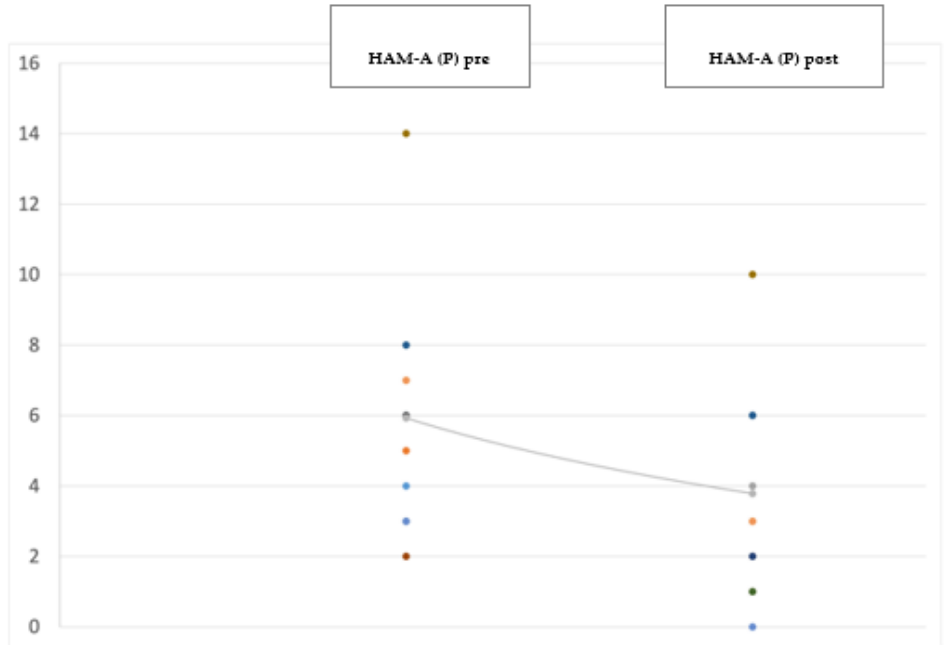
Figure 3. Jittered scattered plot showing the preoperative ( left ) and postoperative ( right ) physiologi- cal anxiety subscore of the Hamilton Anxiety Rating Scale. The difference between the preoperative ONmed and postoperative ONstim showed a p -value = 0.001. The line shows the negative (improving) trend of the values.